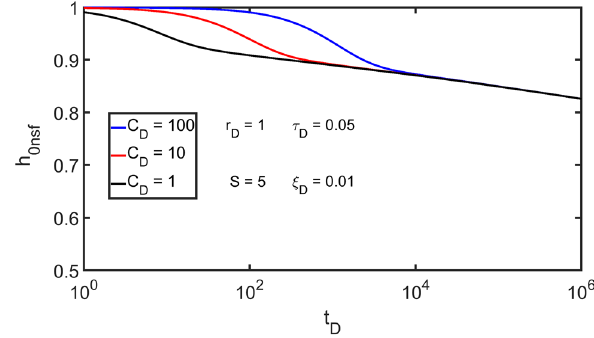
Fig. 4 Semi-log plot of normalized thickness as a function of dimen- sionless time. From Jelmert and Toverud (2017a)